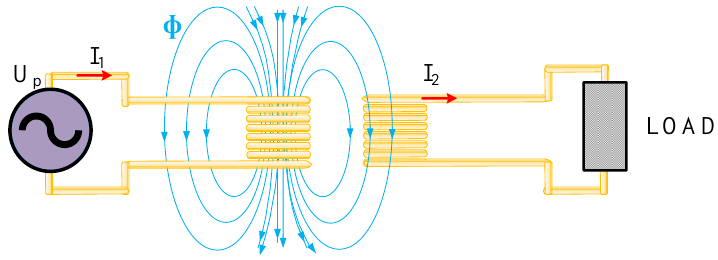
Figure 2. Wireless power transfer using inductive technology.